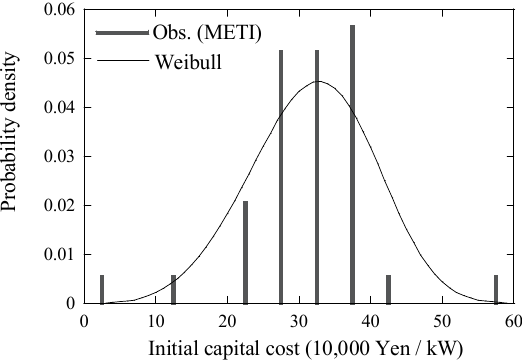
Figure 7. Probability density distribution of CAPEX.